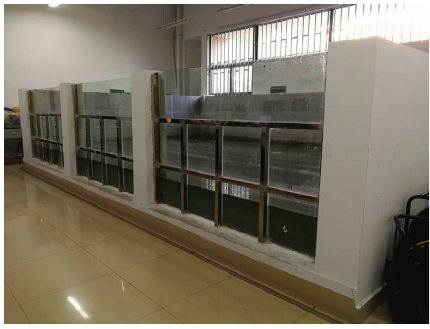
Figure 1: The experiment